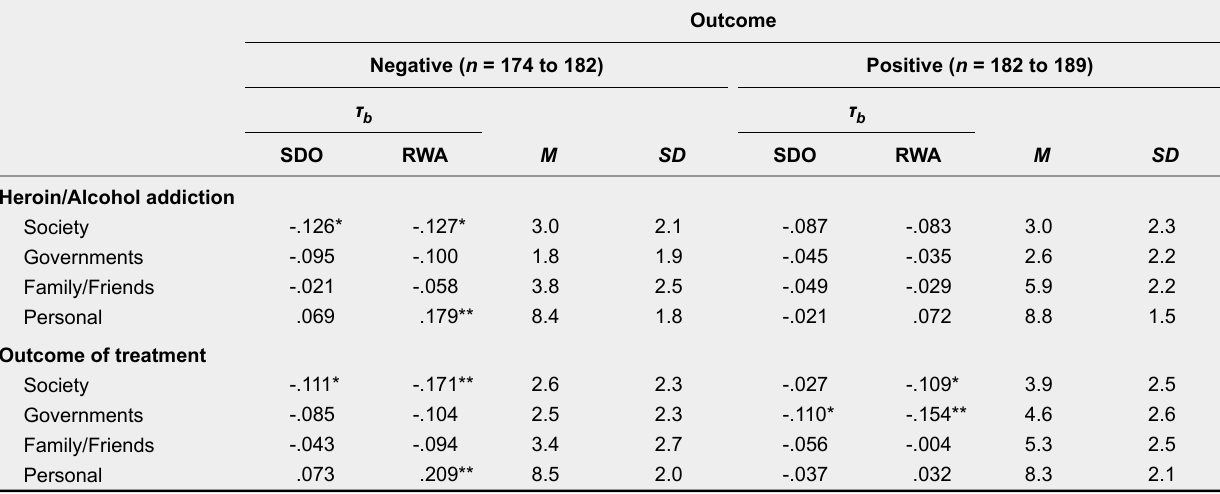
Rank-Correlations (Kendall’s tau b) Between Judgments of Responsibility and the Two Ideological Orientations for Negative and Positive Outcomes, With Means and Standard Deviations for Ratings of Responsibility (Scale From 0 to